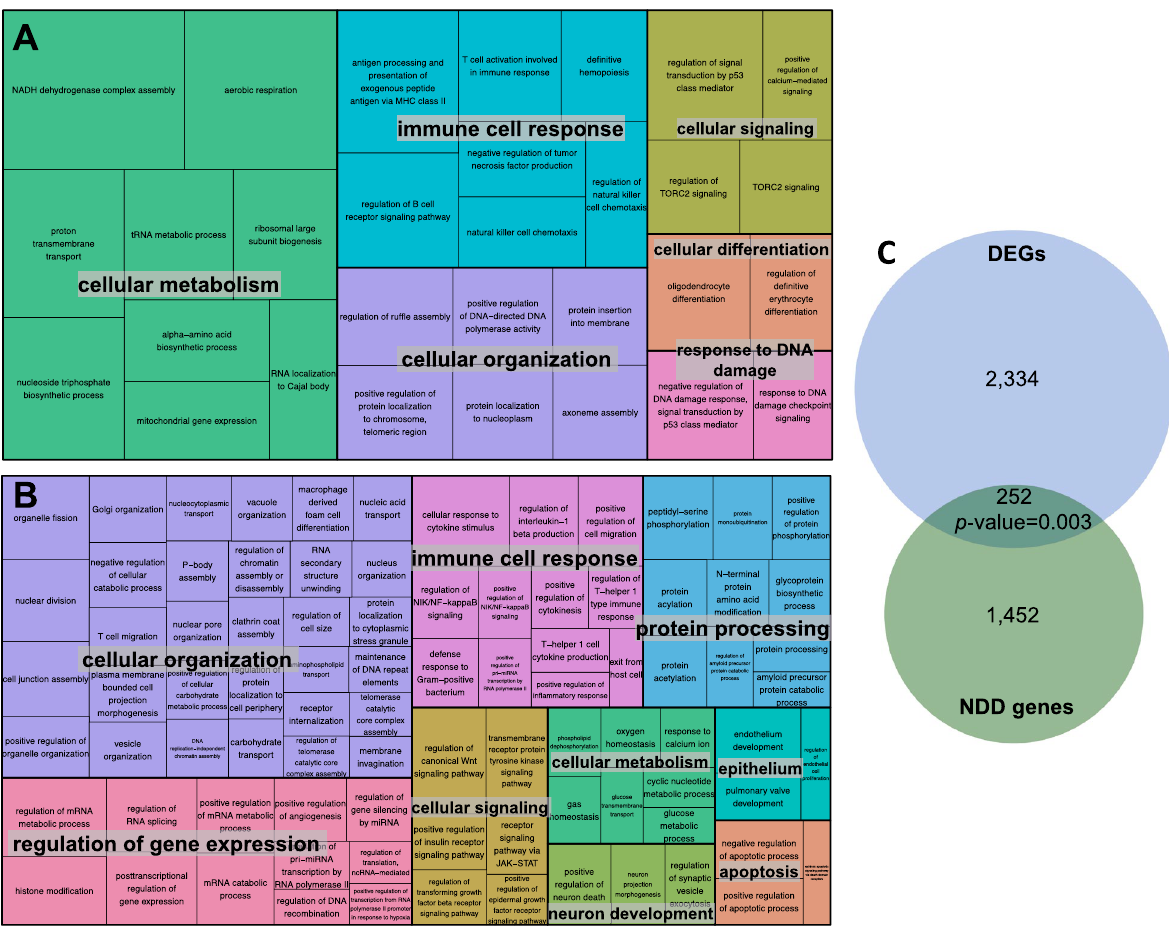
Figure 3. Functional modules representation. ( A ) Activated functional modules clusters in individuals with 15q13.3 microdeletion. Functions that could influence nervous system development are clustered in oligodendrocyte differentiation under the “cellular differentiation” category. The size of the boxes is proportional to the activation level of the module. ( B ) Inactivated functional modules clusters in individuals with 15q13.3 microdeletion. These include processes relevant for neuron development. The size of the boxes is proportional to the inactivation level of the module. ( C ) 252 of the DEGs are related to monogenic neurodevelopmental disorders (NDD). The number of genes is significantly higher than expected by chance ( p -value binomial test =